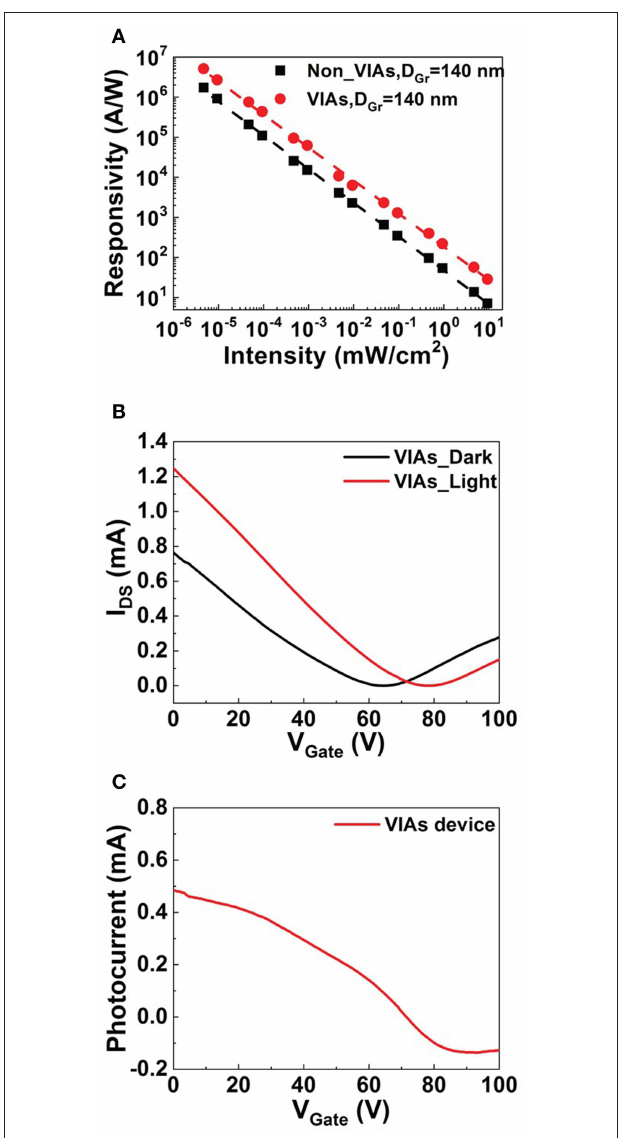
FIGURE 4 | Light response dependence on intensity and gate voltage. Responsively increases as incident power decreases in log-log scale. VIAs device shows superior performance than non-VIA devices across different intensities. Linear plots are shown in section Photoresponse dependence on light intensity in Supporting Information . (B) I DS vs. V G in light and dark conditions for VIAs devices showing ambipolar graphene conductivity reaching the Dirac peak at V G = 65V in dark and V G = 78V in light. (C) I ph vs. V G for VIAs device, showing that photoresponse can be modulated through a gate voltage, reaching negative response for V G > 71.6V. Gate current levels are under 70 nA both under dark and light conditions as shown in section I DS and I Gate as a function of back-gate voltage in Supporting information . In all cases the device has D Gr = 140 and t =